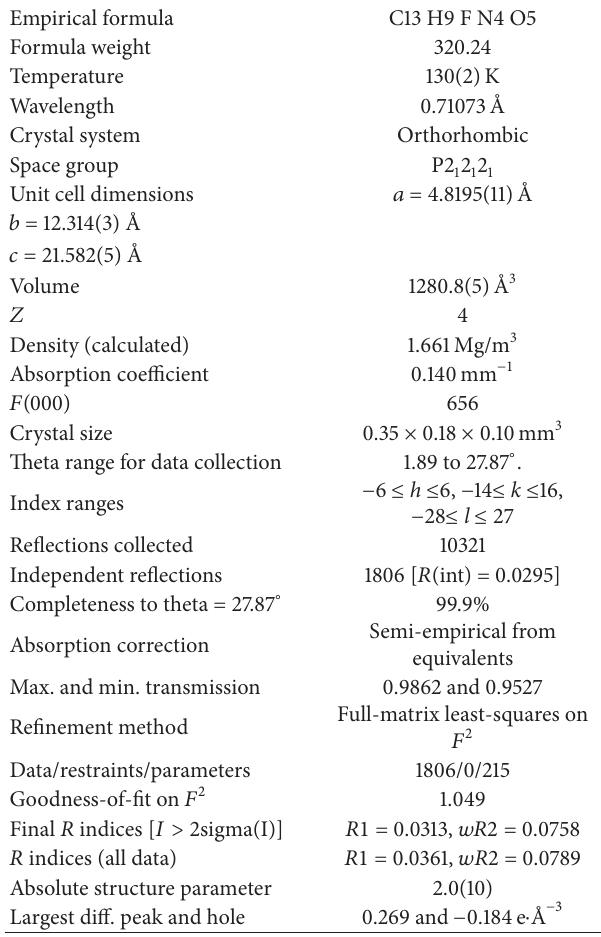
Table 1: Parameter for data collection and structure refinement of 1